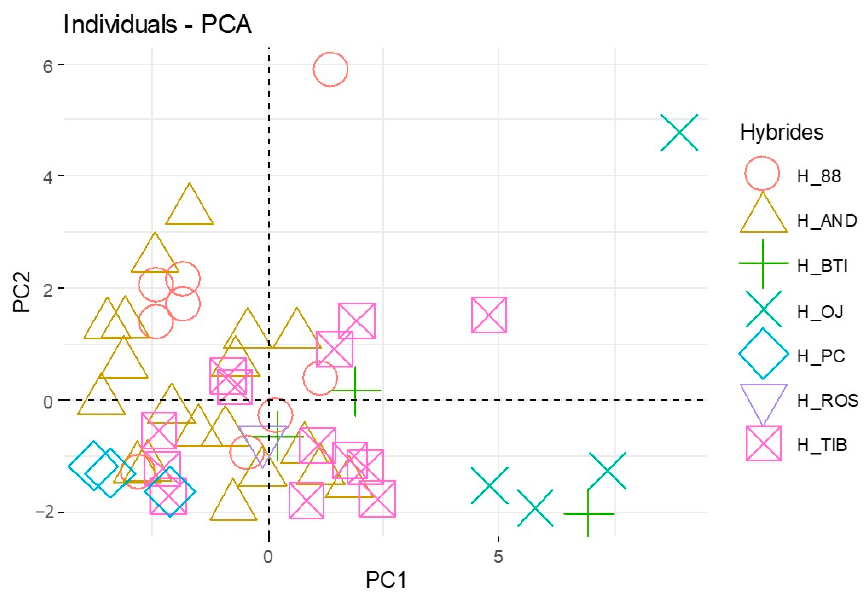
Figure 6. PCA plot released on the hybrids for the 20 molecules retained in the fingerprint of Noir de Bourgogne (mean values). Data from berries collected in 2020; mean values normalized using the weight of berries. Hybrid plants coming from the cross between Noir de Bourgogne and seven other varieties: 88-04-181 (H_88), Andega (H_AND), Ben Tiran (H_BTI), OJ-5-3 (H_OJ), PC110 (H_PC), Rosenthal (H_ROS), and Tiben (H_TIB).